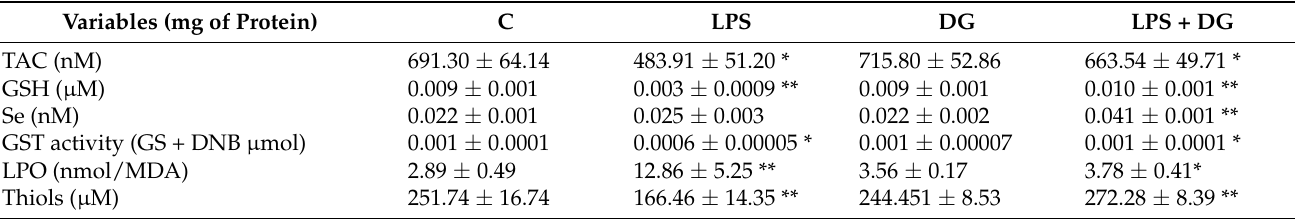
Table 1. Oxidative stress markers in the rat heart homogenate of the experimental